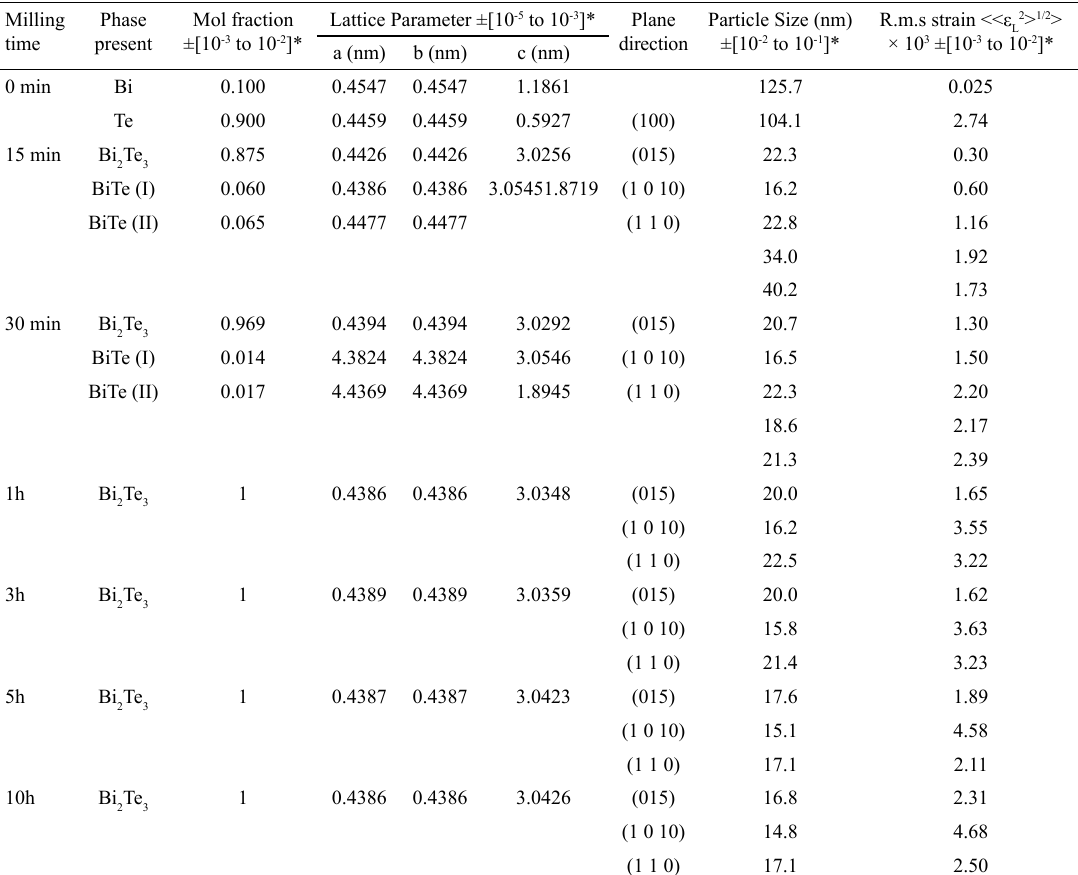
Te phase with Figure 4. Variation of crystallite sizes of Bi 2 3 milling Te revealed by Rietveld’s X-ray powder structure refinement analysis. 2 3